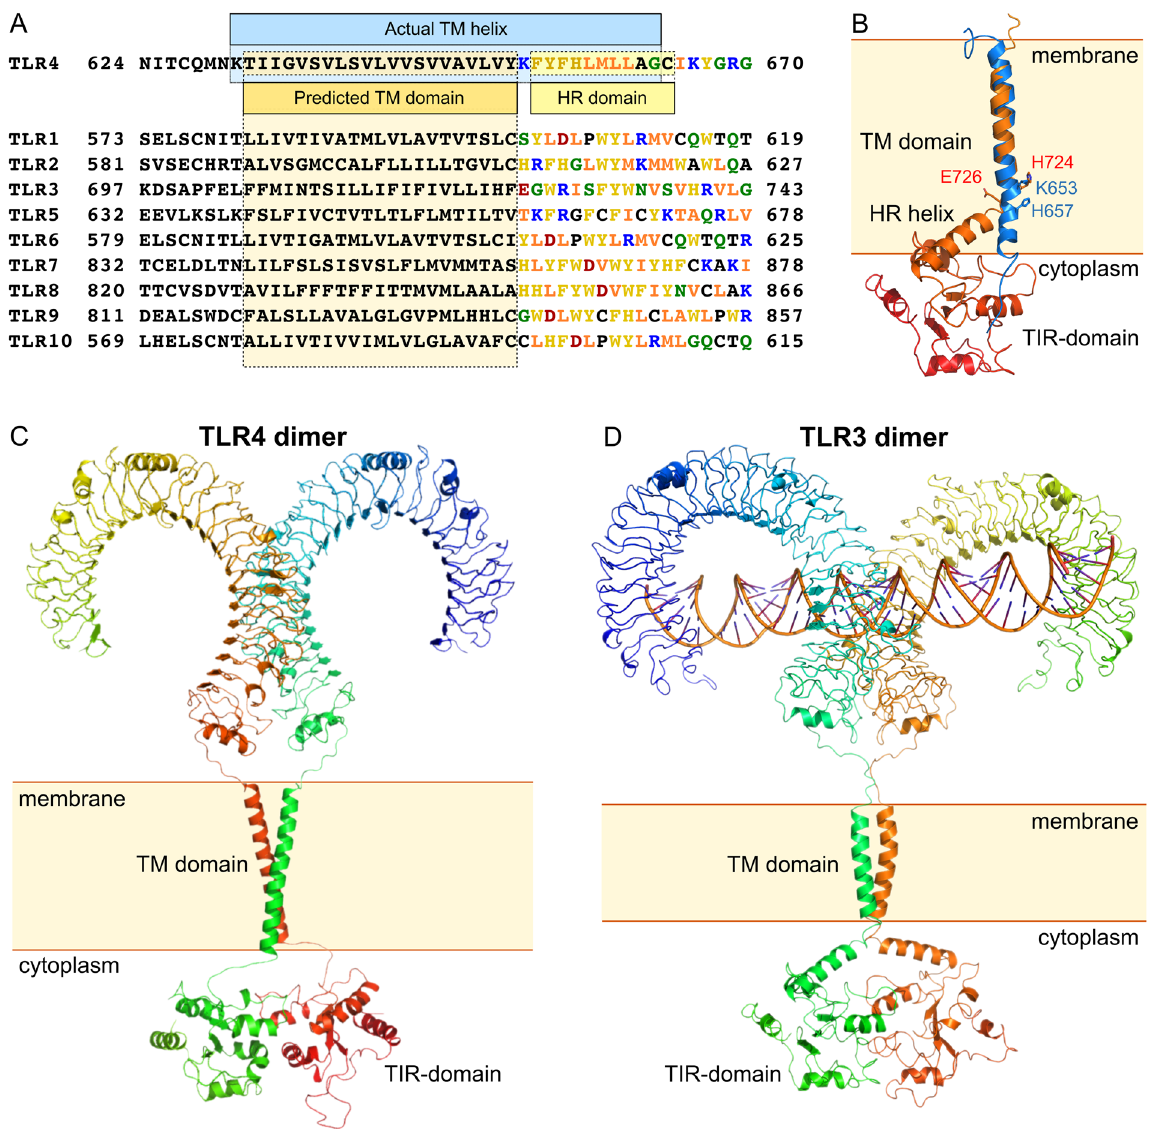
Figure 5. TM domains of human toll-like receptors. ( A ) Sequence alignment of human TLR members. Residues in the predicted cytoplasmic juxtamembrane regions are colored according to their physical properties. Hydrophobic residues are shown by orange (ILVM), aromatic – by yellow (HWFY), positively charged – by blue, negatively charged – by red, polar – by green (GSQN), neutral – by black (APTC). The predicted (according to UniProt) TM domain and HR region, homologous to the reported by Nishiya et al . 23 are indicated. ( B ) The reported structure of TLR4-TMICL (blue) is superimposed with the TM domain of TLR3 in the model of the full-size receptor (brown-red) 6 . Key H and charged residues on the interface between the predicted TM and ICL domains are indicated and signed. ( C ) Model of full-length TLR4 receptor, constructed based on the X-ray structures of ECDs and TIR domains and reported NMR data. ( D ) model of the full-length TLR3 receptor, proposed by Liu et al . 6 . Coordinates were provided by David Davies,